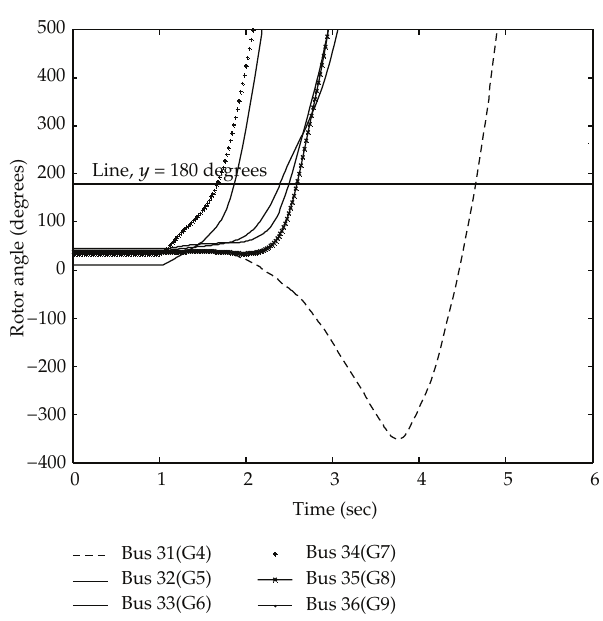
Figure 14: Individual COI-referred rotor angles of generators in Area